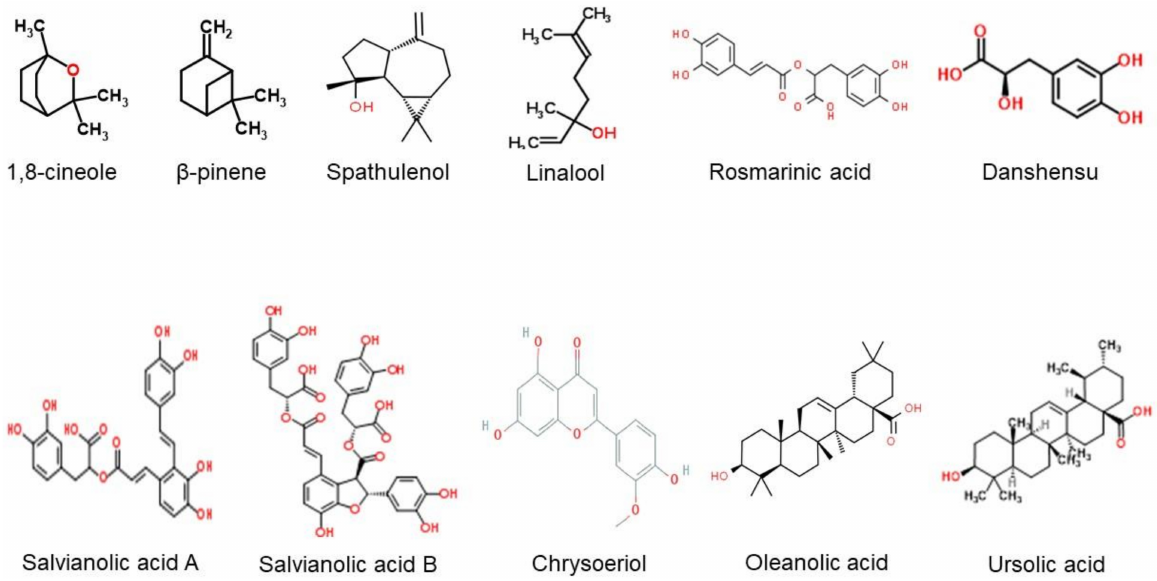
Figure 2. The chemical structures of several main chemical constituents (source: